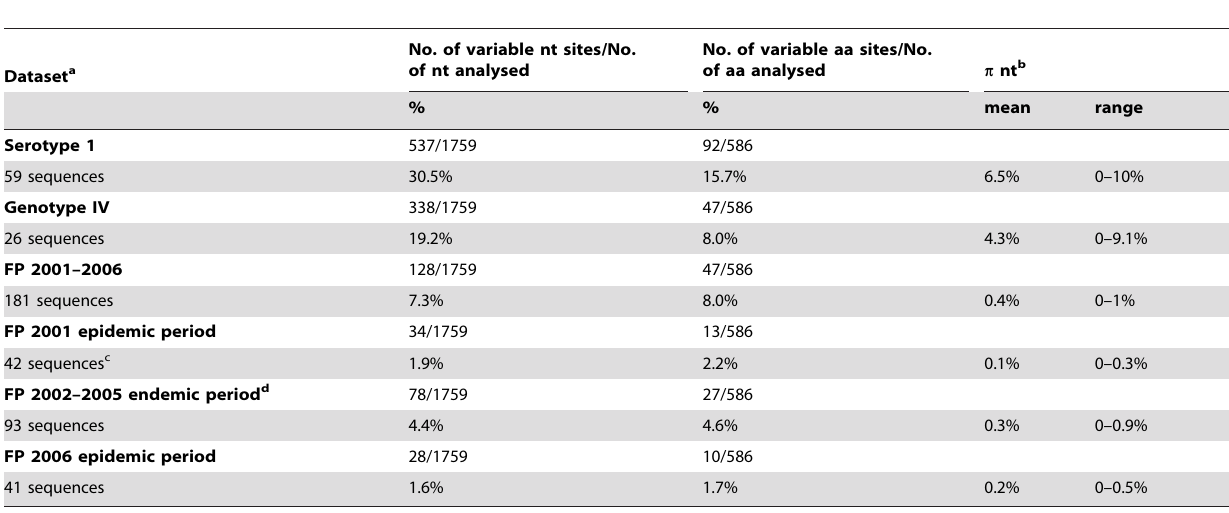
Table 3. Genetic diversity of DENV-1 at different levels and at different times of viral evolutionary divergence based on a 1,759 nt fragment including the